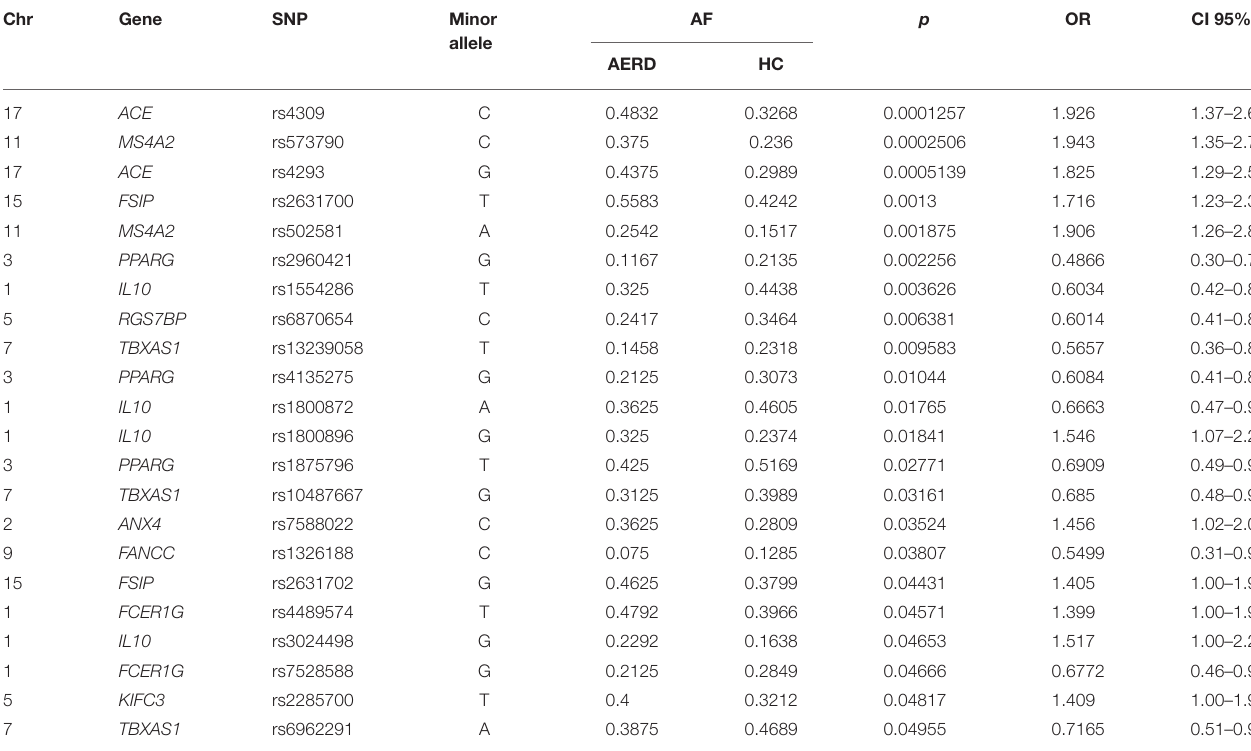
AERD,Aspirin-Exacerbated RespiratoryDisease; ACE,angiotensin Iconverting enzyme; AF, Allelefrequency; ANX4,annexin A4;CI95%,Confidence interval at95%;Chr,Chromosome; FANCC,FanconianemiacomplementationgroupC;FCER1G,FcfragmentofIgEreceptorIg;FISP,interleukin24;HC,HealthyControl;IL10,interleukin10;KIFC3,kinesinfamilymember C3;MS4A2,membranespanning4-domainsA2;OR,Oddsratio;PPARG,peroxisomeproliferatoractivatedreceptorgamma;RGS7BP,regulatorofGproteinsignaling7bindingprotein; SNP, single nucleotide polymorphism; TBXAS1, thromboxane A synthase